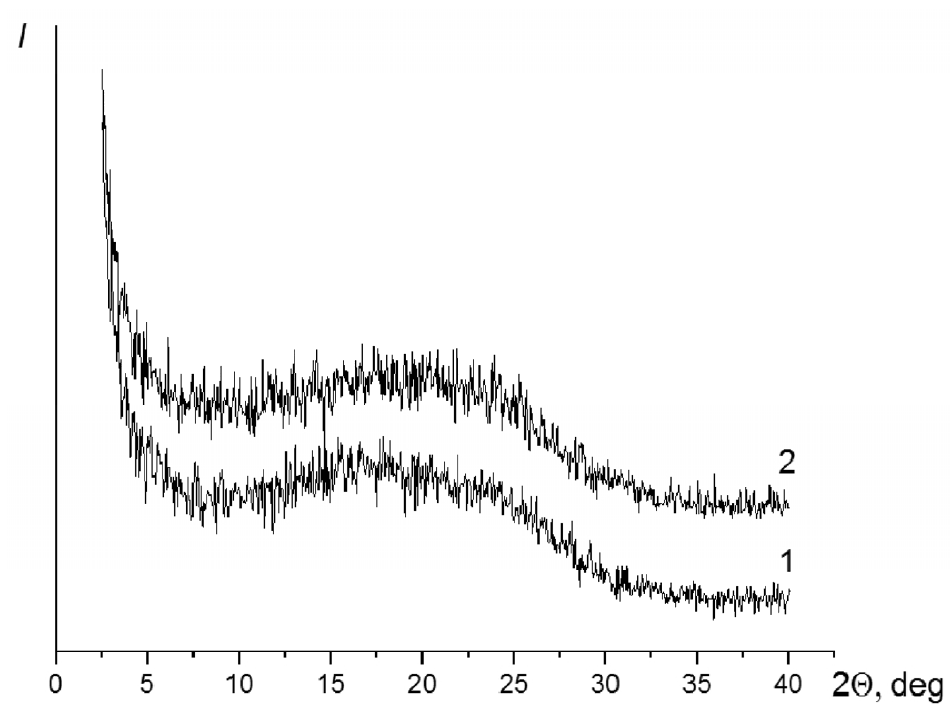
Figure 7. Diffraction patterns of the coPAI-2 membrane, taken from the side of the glance layer (1) and from the matte side (2).